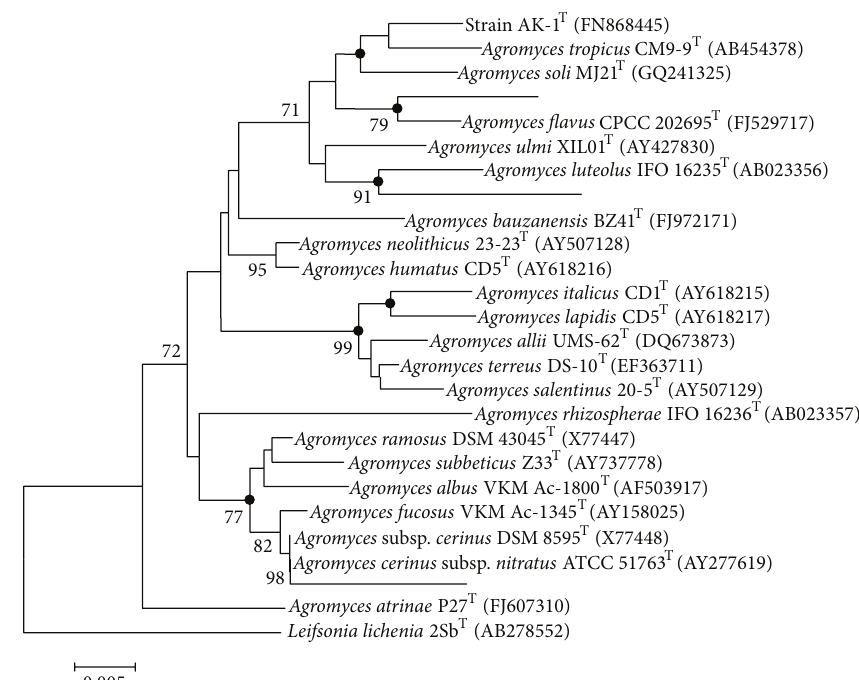
Figure 1: Phylogenetic neighbour-joining tree based on 16S rRNA gene sequences (1442 bases) showing the relationship between Agromyces arachidis AK-1 T and related members of the genus Agromyces. Leifsonia lichenia 2Sb T (AB278552) was used as an outgroup. Bootstrap values (expressed as percentages of 1000 replications) greater than 70% are given at nodes. Filled circles indicate that corresponding nodes were also recovered in the tree generated with maximum parsimony and maximum likelihood algorithms. Bar, 0.005% sequence variation. GenBank accession numbers are given in parentheses. Table 2: Percentage of total cellular fatty acids from strains AK-1 T (MTCC 10524 T ), A. aurantiacus (MTCC 11069 T ), A. soli (MTCC 11074 T